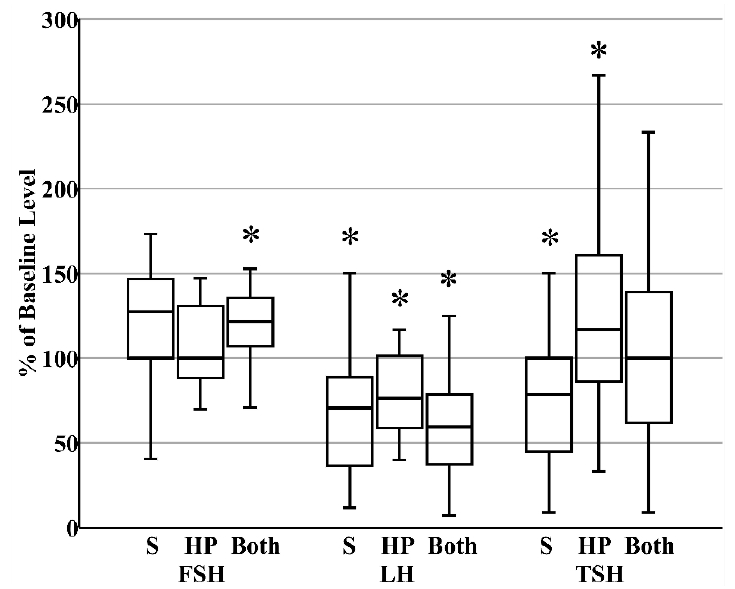
Figure 3. Summary of the changes that occur in the concentrations of pituitary glycoproteins after refrigerated storage (S, N = 27, all maternal), holder pasteurization (HP, N = 30, all donor), or both storage and holder pasteurization ( N = 30, all donor). * p < 0.05 versus fresh raw milk.